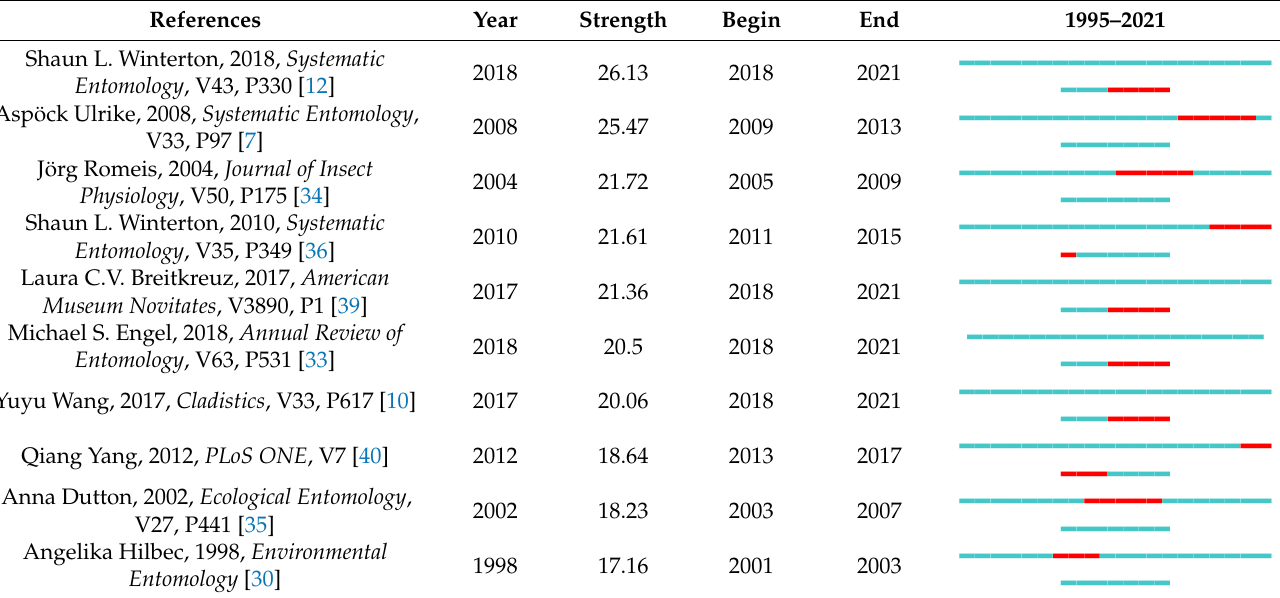
Figure 9. Timelines of co-citation clusters. Table 8. Top 10 references based on citation burst